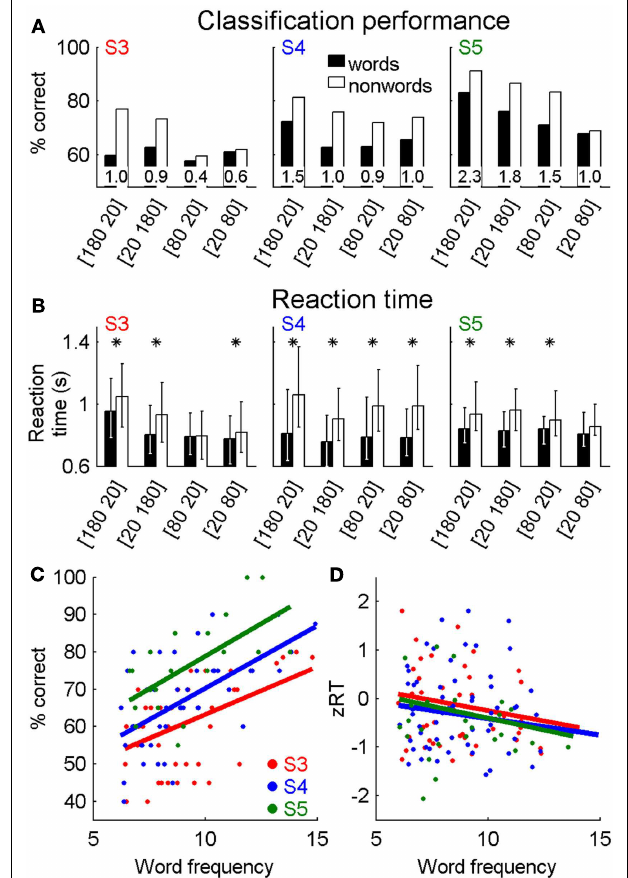
FIGURE 4 | Lexical decision task. Words and non-words were correctly identified at higher than chance levels (A) with d (cid:48) > 0 for each timing condition ( d (cid:48) values are inset within each pair of bars).The number pairs indicate the timing of letter presentation [ t visible t gap ]. Median reaction times were typically shorter for correctly identified words than non-words (B) , with asterisks indicating median reaction times that are significantly different (rank-sum test, p < 0.05). For true words, word frequency (log HAL frequency) was positively correlated with accuracy (C) and normalized reaction times [ z RT, (D) ]. Data is based on judgments of 1596 (S3), 1748 (S4), and 720 (S5) words and